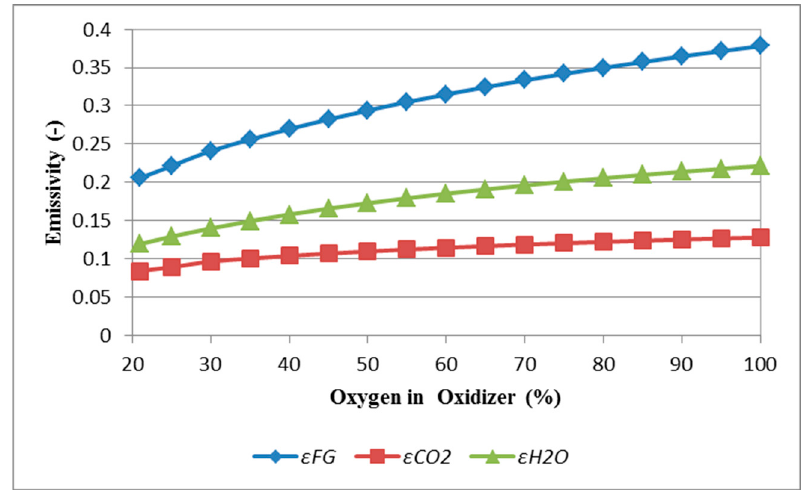
Figure 4. Graphical dependence of the emissivity of flue gas ε FG , ε CO 2 , and ε H 2 O from the oxidizer oxygen concentration (mathematical modelling).